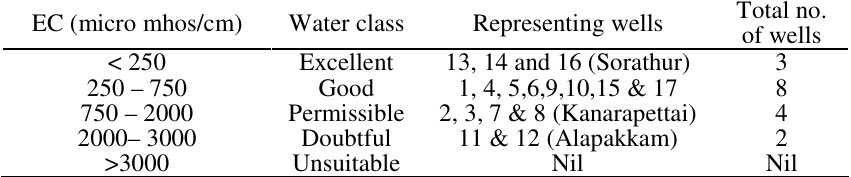
Hydrogen ion concentration